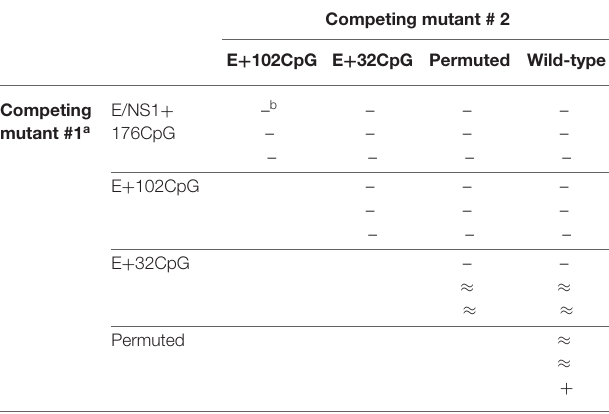
TABLE 3 | In vitro competition assay with ZIKV variant-specific restriction